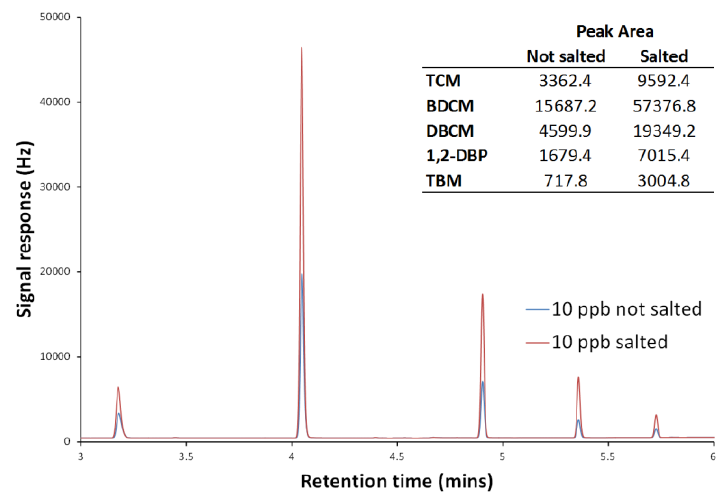
Figure 3. Chromatograms of spiked samples containing TCM (3.17 min), BDCM (4.04 min). DBCM (4.90 min), 1,2-DBP as internal standard (5.38 min) and TBM (5.75 min) with one sample salted and one not salted. Inset table indicates the peak areas of the target analytes in both samples.